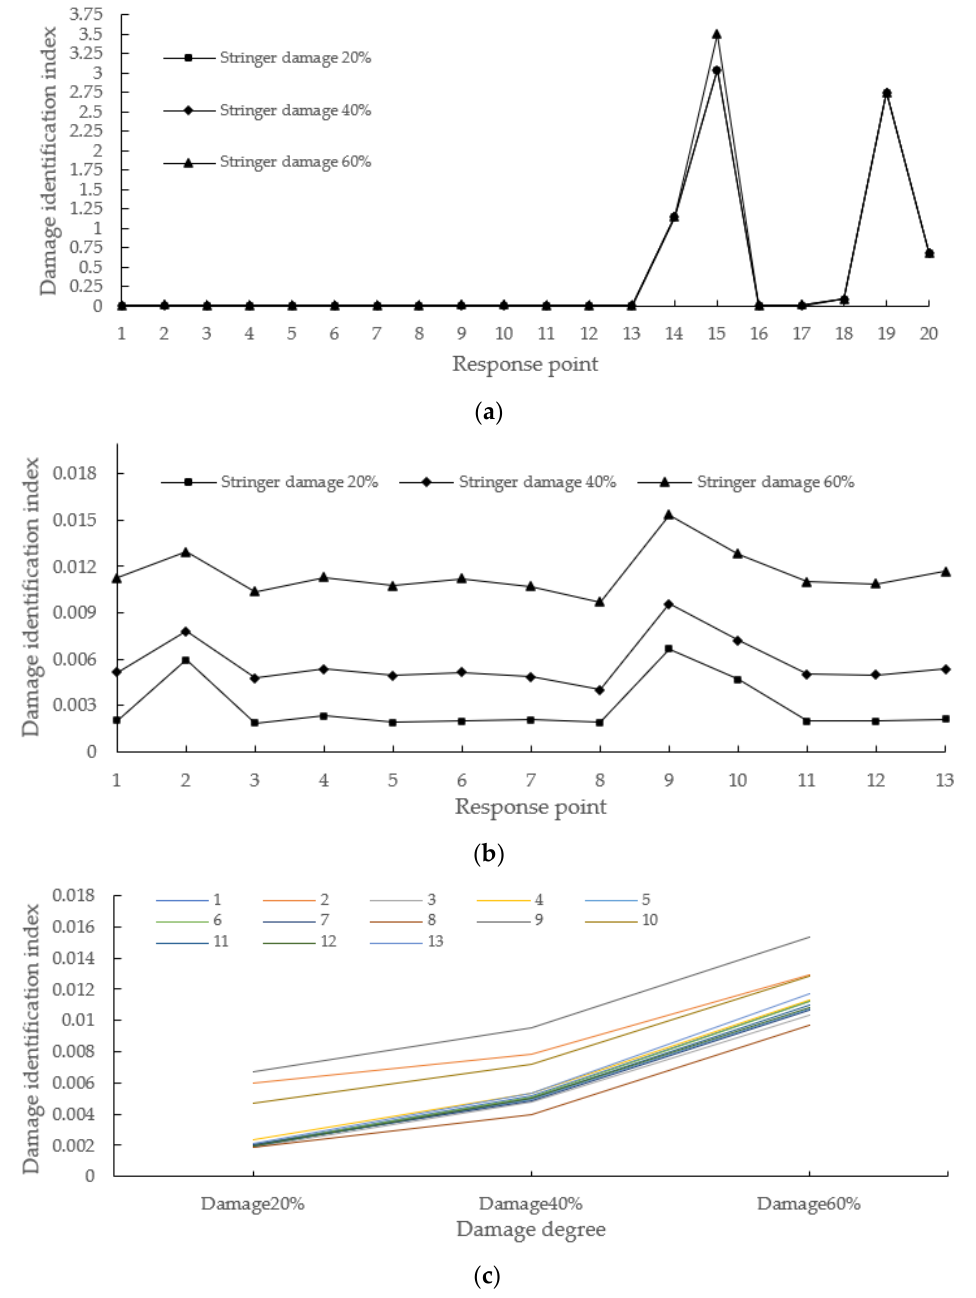
Figure 7. Variation curves of damage identification index at each response point under different damage degree of longitudinal beam . (a) The damage identification indices of 1-20 response points. (b) The damage identification indices of 1-13 response points. (c) Growth trend curves of damage identification indices of 1-13 response points with increasing damage degree.